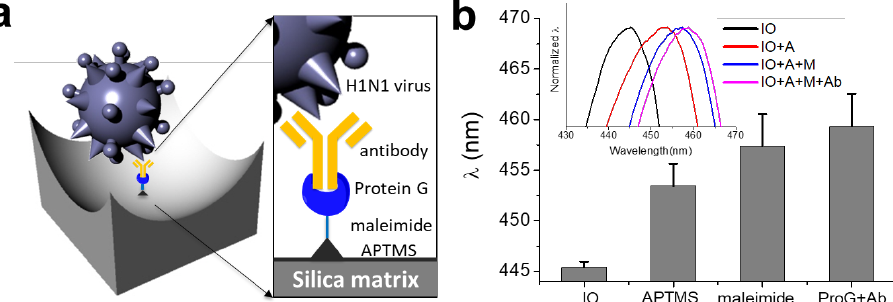
Figure 3. ( a ) Schematic illustration showing the molecular structures formed by the surface functionalization on the IO nanostructure for binding the H1N1 subtype; ( b ) Reflectance peak positions for the pristine, APTMS-treated, NHS-PEG 4 -Maleimide cross linker-treated, and Cys-ProG -antibody immobilized IOs. Inset shows reflectance spectra for all four samples. APTMS: 3- aminopropyl trimethoxysilane.